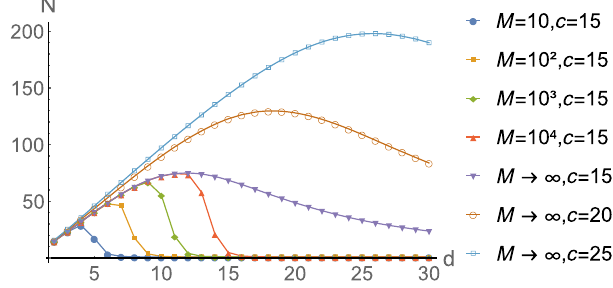
FIG. 4. The effect of the ladder dimension d on the clock accuracy N for different M . The top three curves show this effect